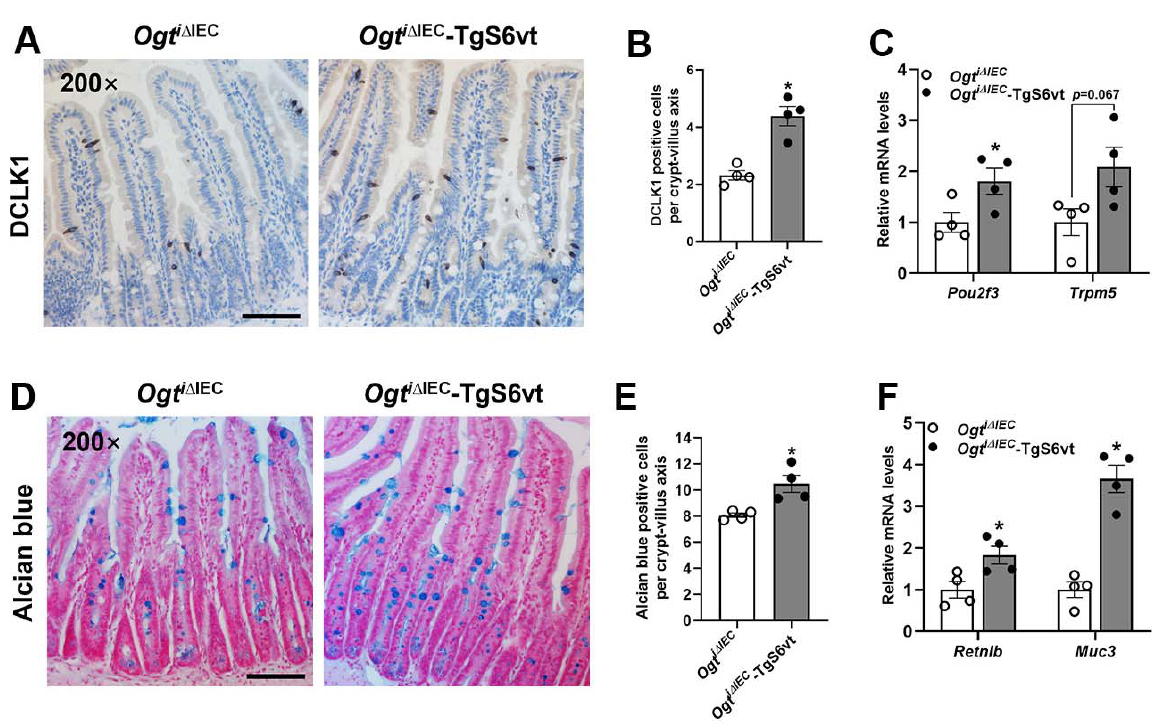
Figure 5. STAT6 activation promotes intestinal tuft and goblet cell differentiation in Ogt i ∆ IEC mice. The 9–11-week-old male Ogt i ∆ IEC and Ogt i ∆ IEC -TgS6vt mice were subjected to the following analyses. ( A ) Jejunal tuft cells were examined by DCLK1 IHC staining. ( B ) Quantification of tuft (DCLK1 positive) cells shown in ( A ) ( n = 4/group, 20 crypt-villus units counted for each mouse). ( C ) qPCR analysis of tuft cell markers expression in the jejunal IECs ( n = 4/group). ( D ) Jejunal goblet cells were examined by Alcian blue staining. ( E ) Quantification of goblet (Alcian blue positive) cells shown in ( D ) ( n = 4/group, 20 crypt-villus units counted for each mouse). ( F ) qPCR analysis of goblet cell markers expression in the jejunal IECs ( n = 4/group). Data are presented as mean ± SEM. * p < 0.05. Scale bars, 100 μ m.